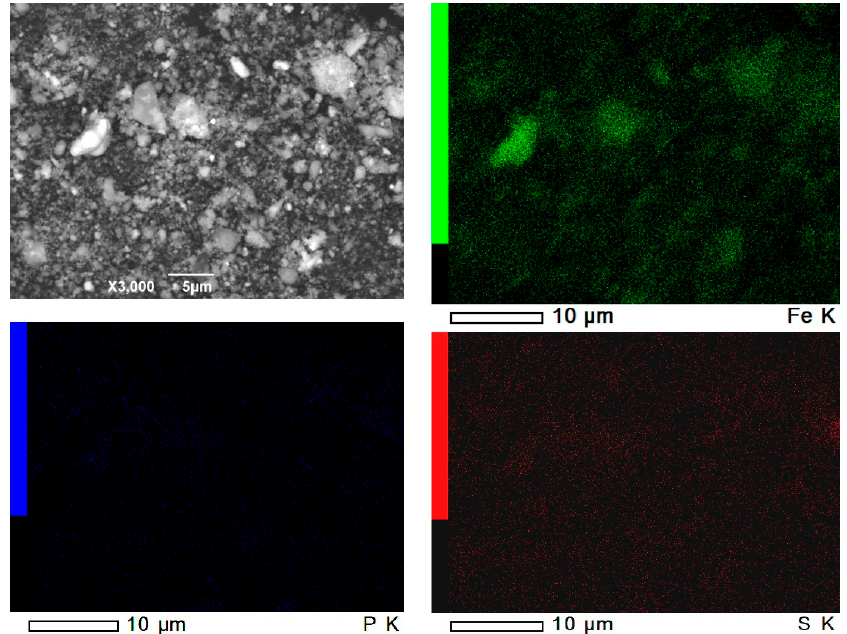
Figure 12. SEM image (backscattered electron BEC) of the roasted RM with the distribution of S, P and Fe at T = 1000 °C, t = 5 min, 13.65% Na 2 SO 4 .